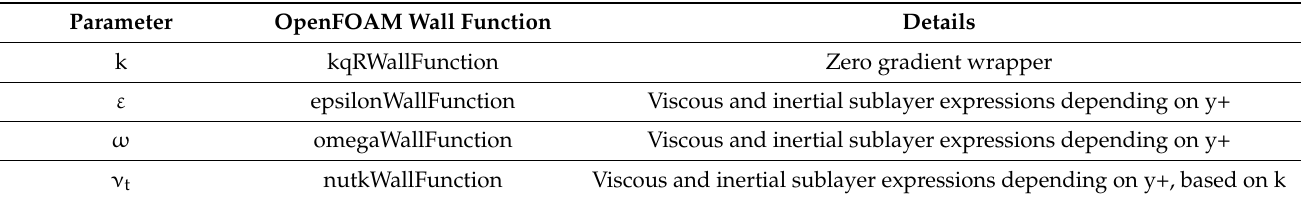
Table 2. Used wall